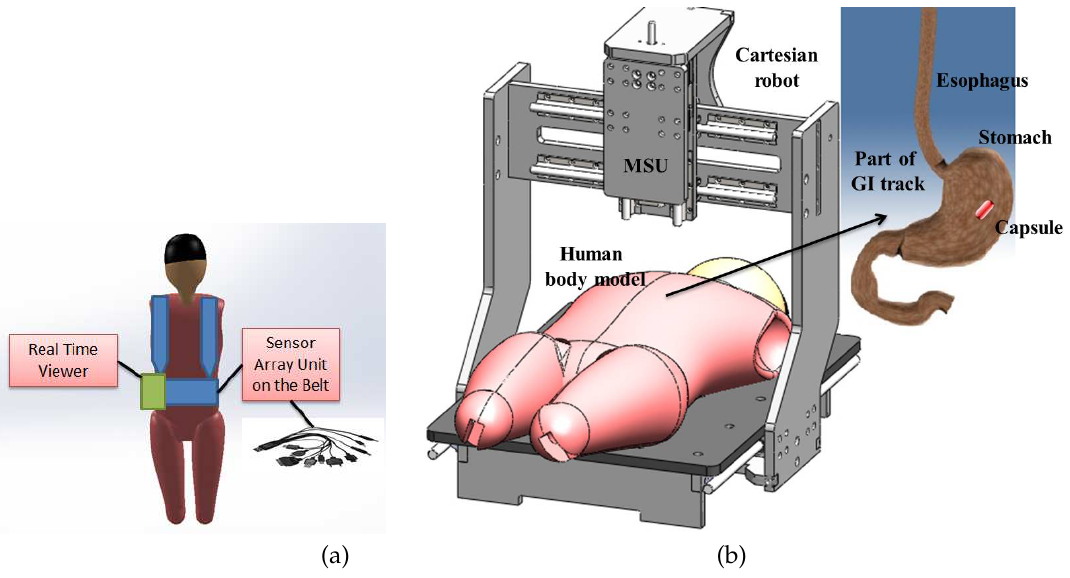
Figure 3. ( a ) WCE receiver set; ( b ) a robotic navigation system for gastric capsule